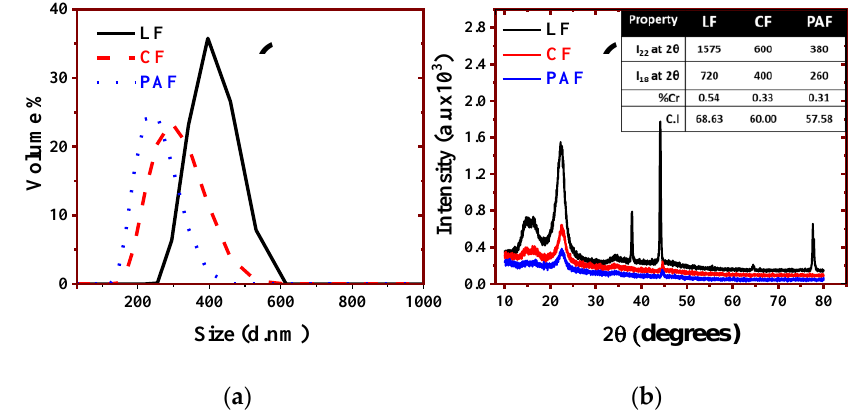
Figure 1. ( a ) Particle size distribution and ( b ) PXRD profiles of linen fiber (LF) and its treated forms (CF and PAF). Figure 1b, inset; XRD parameters for the crystallinity index (C r I) and peak intensities at 2θ = 22° and 18°.